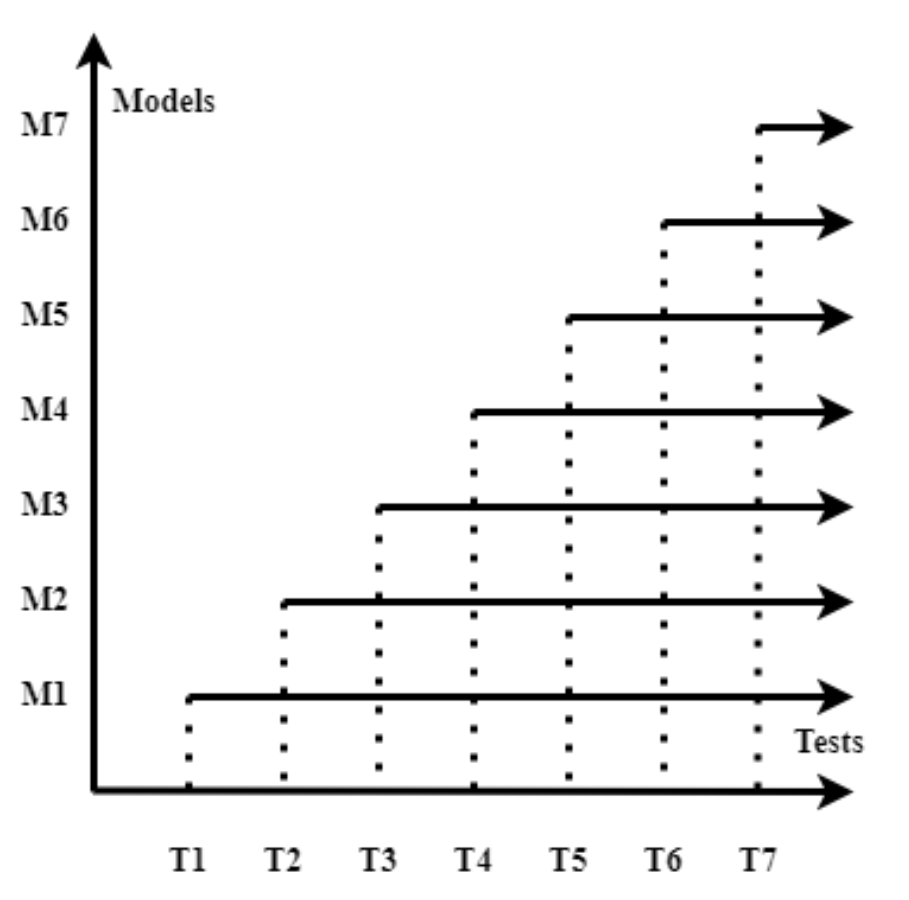
Figure 3. Models built for 10 quizzes.